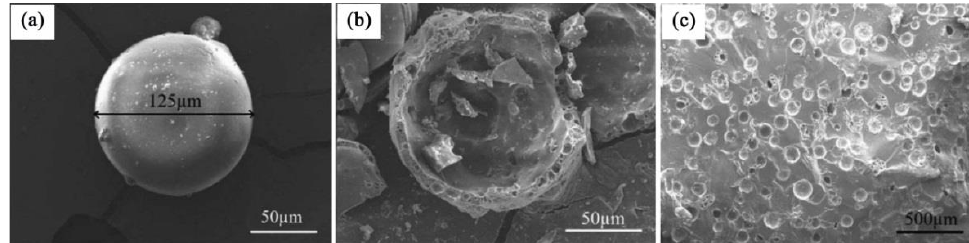
Figure 6. SEM images of fly ash (FA) and fly ash/polyurea (FA/PU) composites: ( a ) intact fly ash; ( b ) broken particles; ( c ) FA/PU composites. Reproduced with permission from ref. [27].